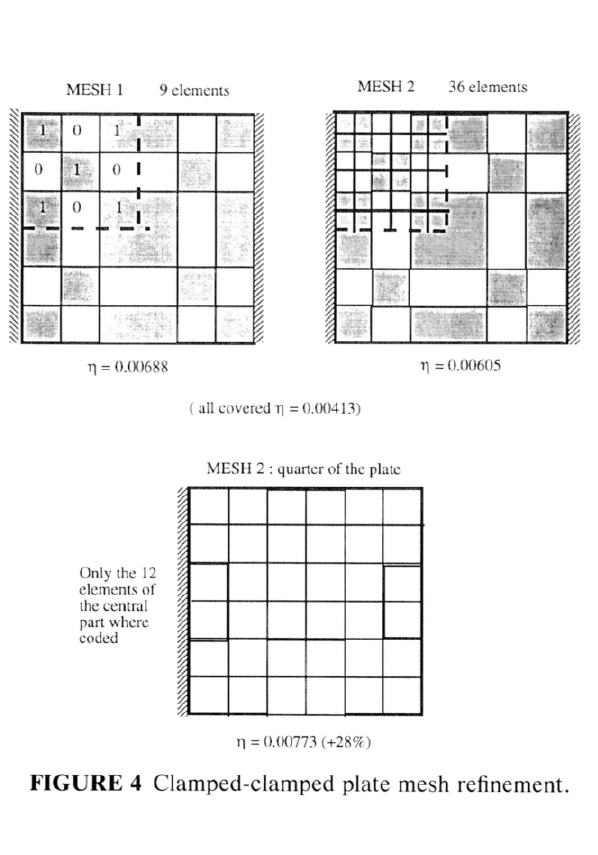
FIGURE 4 Clamped-clamped plate mesh